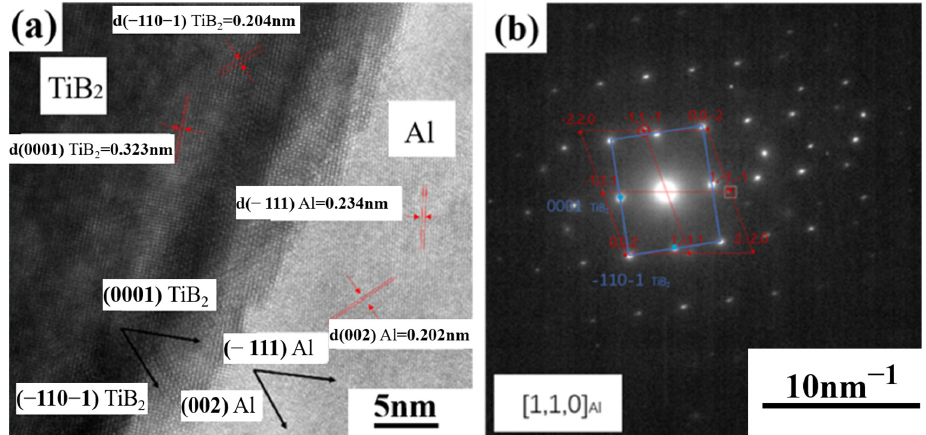
Figure 10. ( a ) HRSTEM image of the interface between micron-TiB 2 particle and Al matrix in SLM- fabricated TiB 2 /AlZnMgCu(Sc,Zr) composite and ( b ) indexing of the SAED patterns, showing relative orientation relations (ORs).